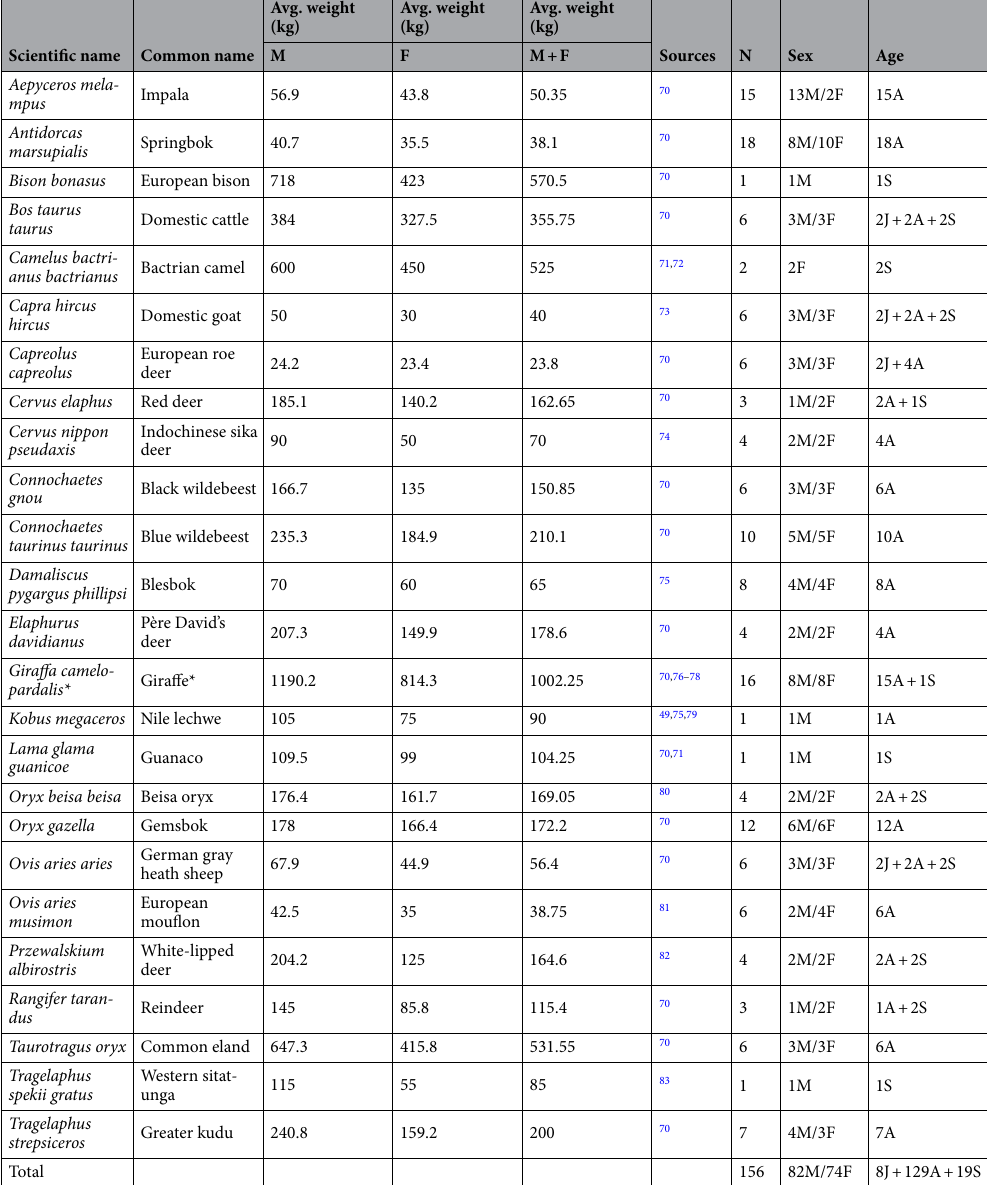
Table 2. List of taxa (ordered alphabetically according to the scientific name) with common names, average weight of species extracted from the literature, and individuals inspected in this study. *We evaluated a population equivalent to the Angolan giraffe (= angolensis Lydekker, 1903). avg. average, N sample size, sex: F female, M male, age : A adult, J neonate or juvenile, S